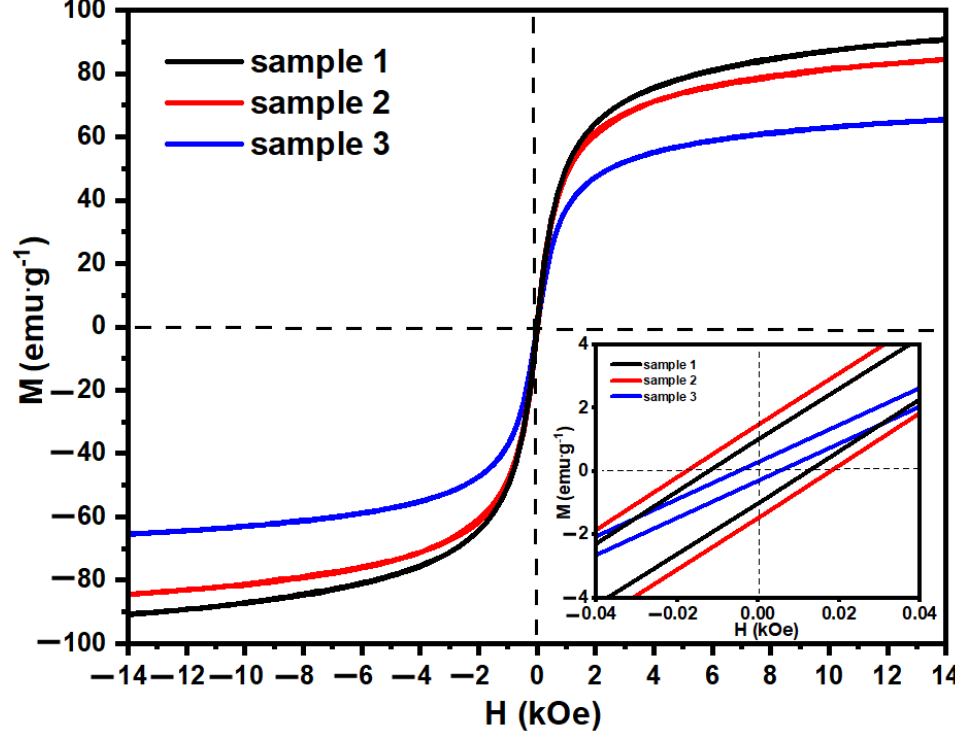
Figure 4. Magnetic change in function of magnetic field for samples 1–3.